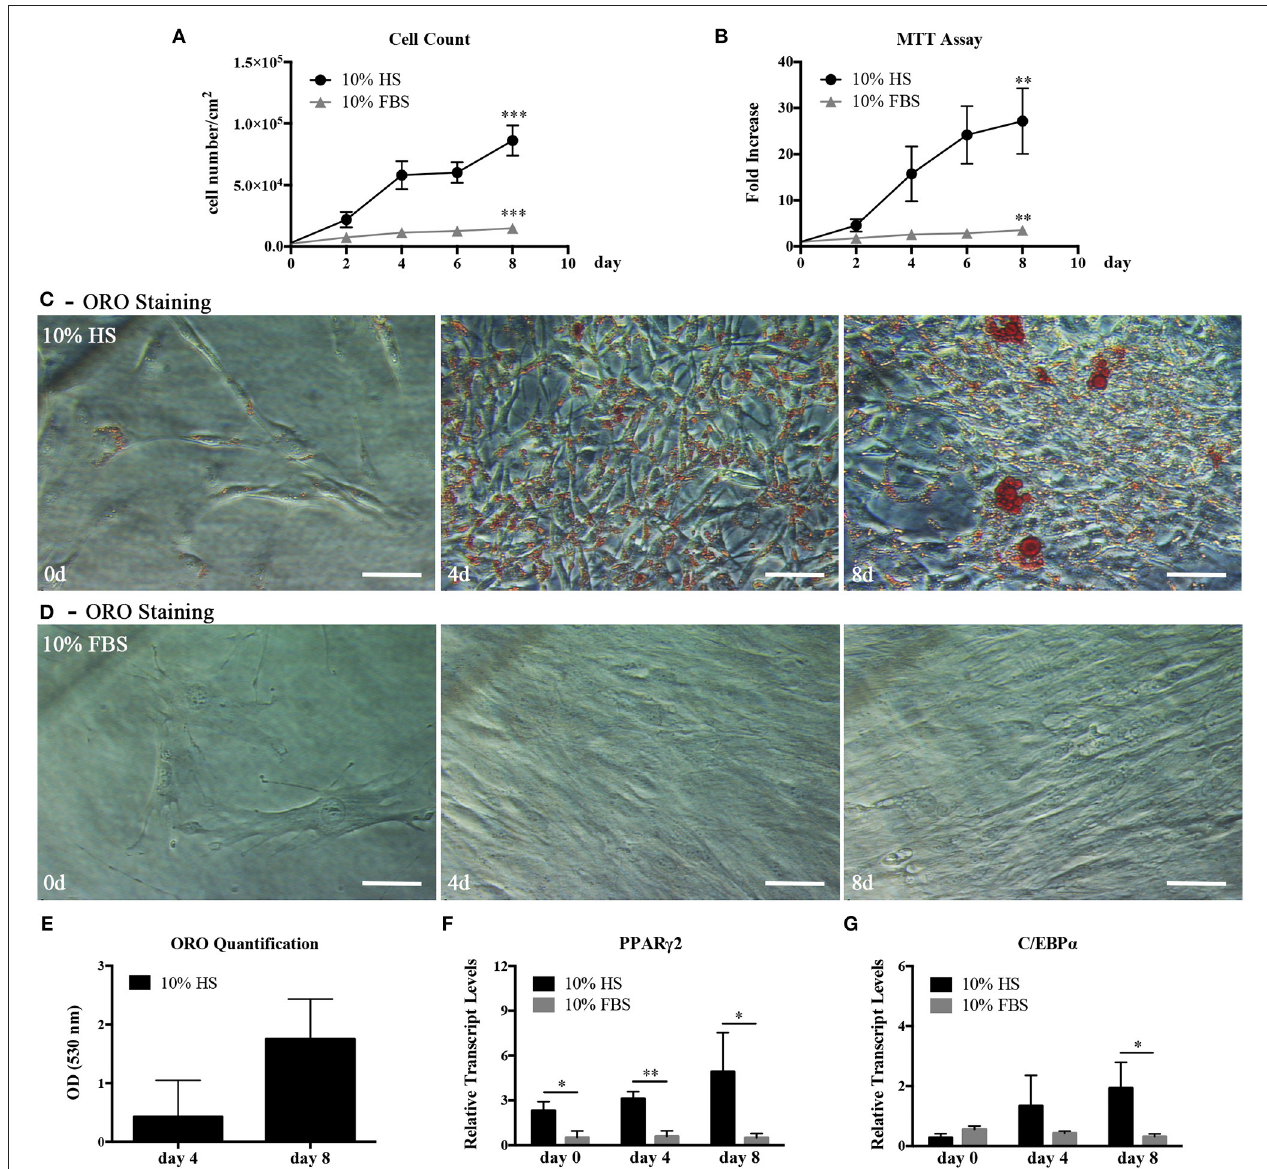
FIGURE 1 | hASC isolated and expanded in 10% HS or 10% FBS at passage 2. (A) Cell proliferation monitored by cell counting. Average values ± SD of 3 independent experiments, each one performed in duplicate, are reported. The *** symbol corresponds to p = 0.0006; (B) Cell viability evaluated by MTT assay and expressed as n-fold increase. Average values ± SD of 3 independent experiments, each one performed in triplicate, are reported. The ** symbol corresponds to p = 0.005; (C,D) Representative ORO staining of hASC cultured with 10% HS (C) or 10% FBS (D) for 0, 4, and 8 days (scale bars = 50 µ m); (E) Quantification by spectrophotometric analysis of ORO dye incorporated in HS-expanded hASC, normalized to cell number, at different culture days. Average values ± SD of 3 independent experiments, each one performed in triplicate, are reported; (F,G) Real Time quantitative PCR analysis of PPAR γ 2 (F) and C/EBP α (G) transcript levels in HS- or FBS-expanded hASC at different culture days. Results are expressed as means ± SD values of 3 independent experiments performed each in triplicate. The * and ** symbols refer to p ≤ 0.04 and p = 0.002,